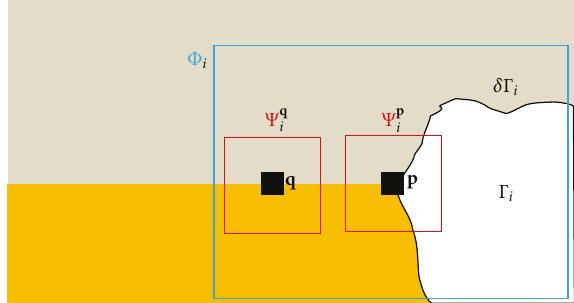
Figure 8: The modified exemplar-based inpainting diagram.